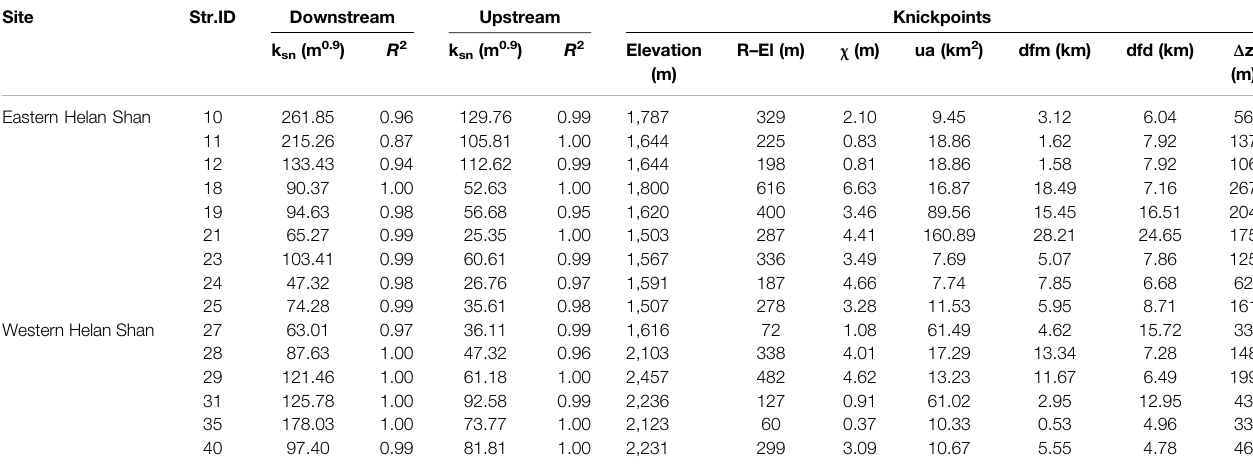
TABLE 1 | Results of the stream pro fi le analysis in the Helan Shan. Site Str.ID